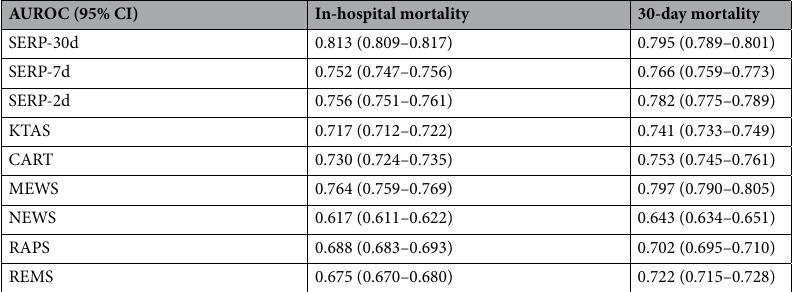
Table 2. Comparison of AUROC by different scores and outcomes. AUROC Area under Receiver Operating Characteristic, CI Confidence Interval, SERP-nd Score for Emergency Risk Prediction for predicting n day